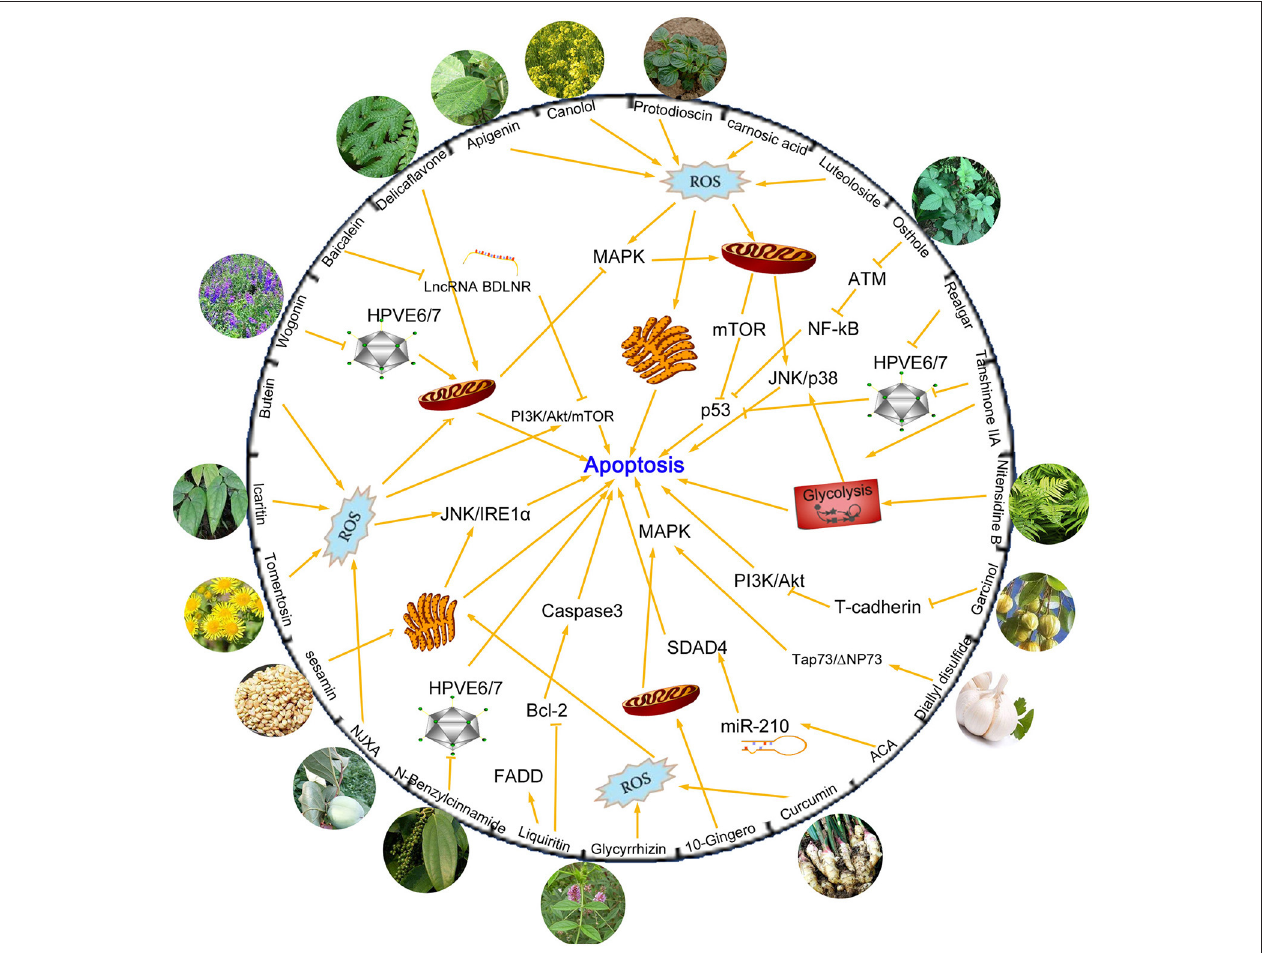
FIGURE 1 | Chemical compounds isolated from plants and mechanisms of their anti-tumor activities by inhibiting apoptosis process. Many compounds are found to exert significant anti-tumor activity. Some of these compounds kill cancer cells by increasing production of ROS levels and then activate mitochondrial or endoplasmic reticulum apoptosis related pathways. HPVE6/E7 proteins are other targets suppressed by novel compounds, which can effectively inhibit the proliferation of cervical cancer cells. MAPK, PI3K/AKT/mTOR, JNK/p38, p53, NF- κ B are classical apoptotic pathways and are involved in the regulatory network of drugs that induce